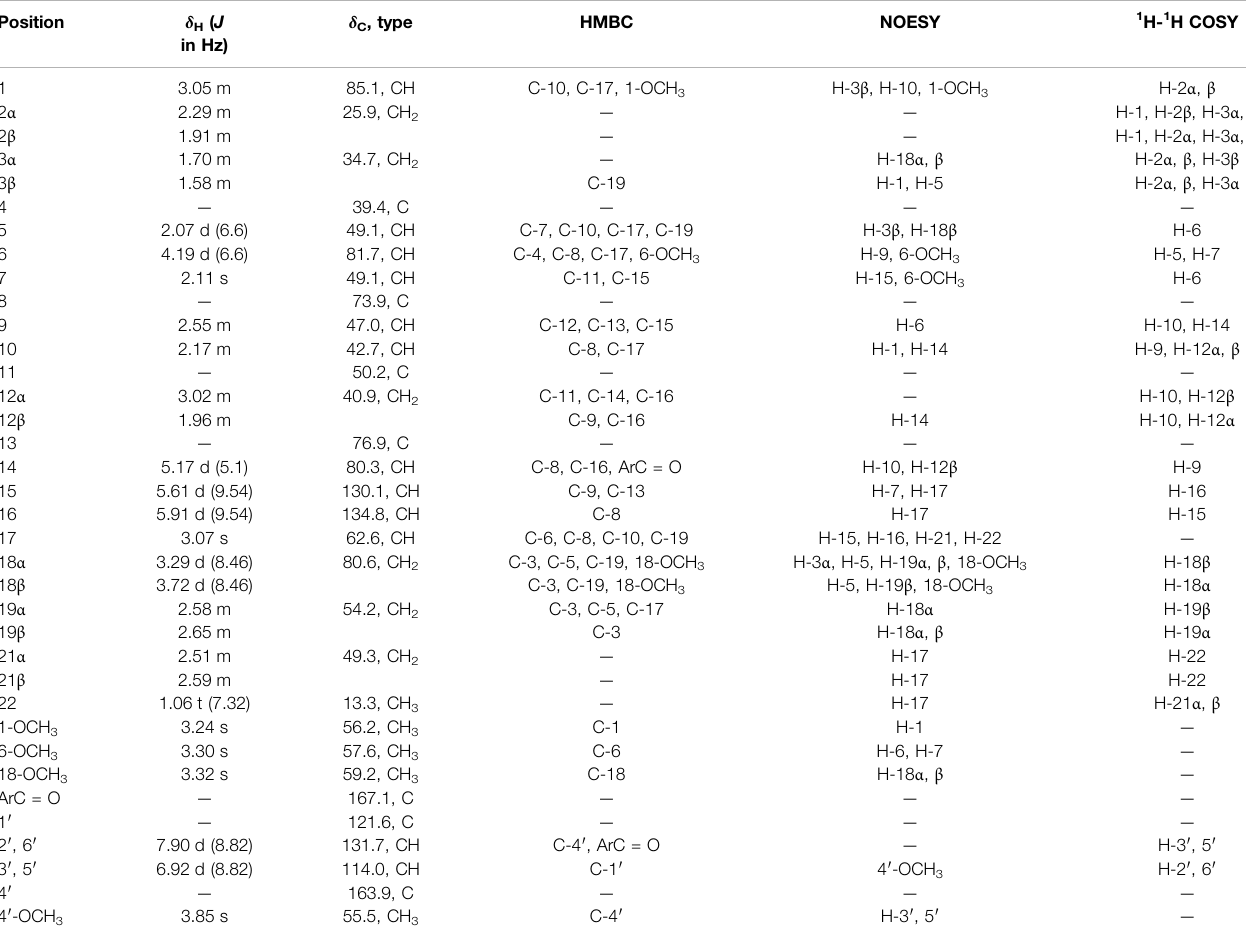
TABLE 1 | 1 H (600 MHz) and 13 C (150 MHz) NMR data for compound 1 (CDCl 3